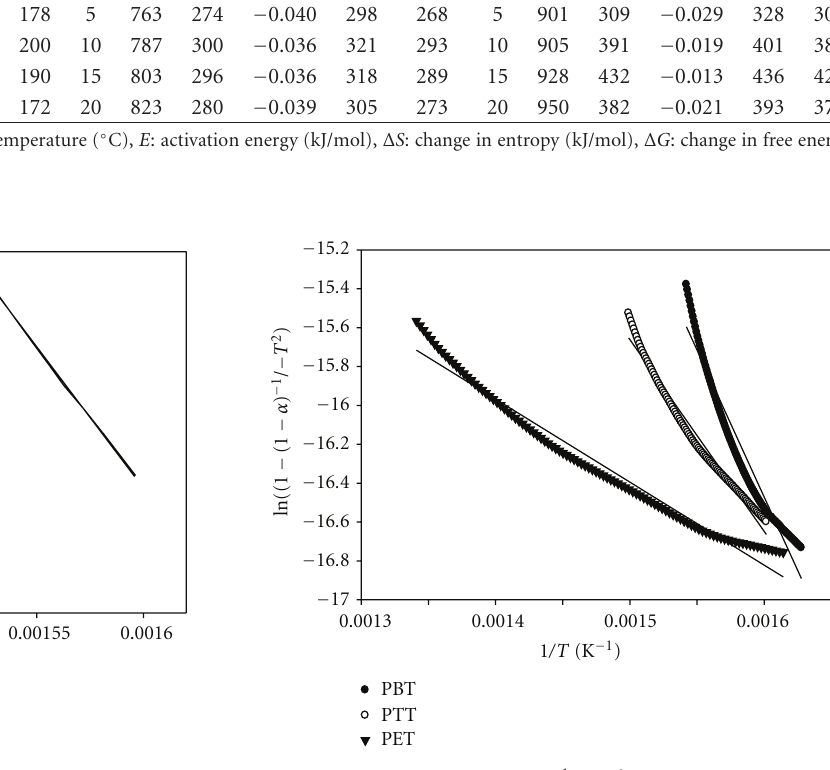
Figure 4: Plot of ln[1 − (1 − α ) − 1 ] / − T 2 versus 1 /T for di ff erent polyesters degraded in N 2 atmosphere (zone